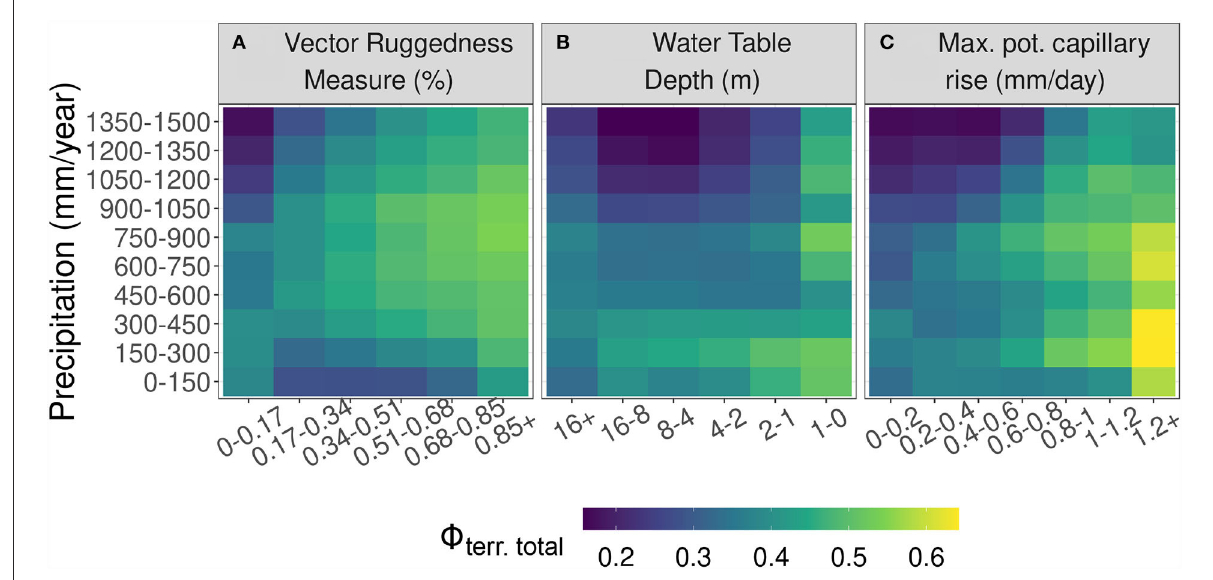
FIGURE4 Effects of aridity on the importance of terrain parameters (refer to Equation 2) with change in Vector Ruggedness Measure (VRM) (A) , Water Table Depth (WTD) (B) , and maximum potential upward capillary flux 1 meter above water table depth ( I cap ) (C)